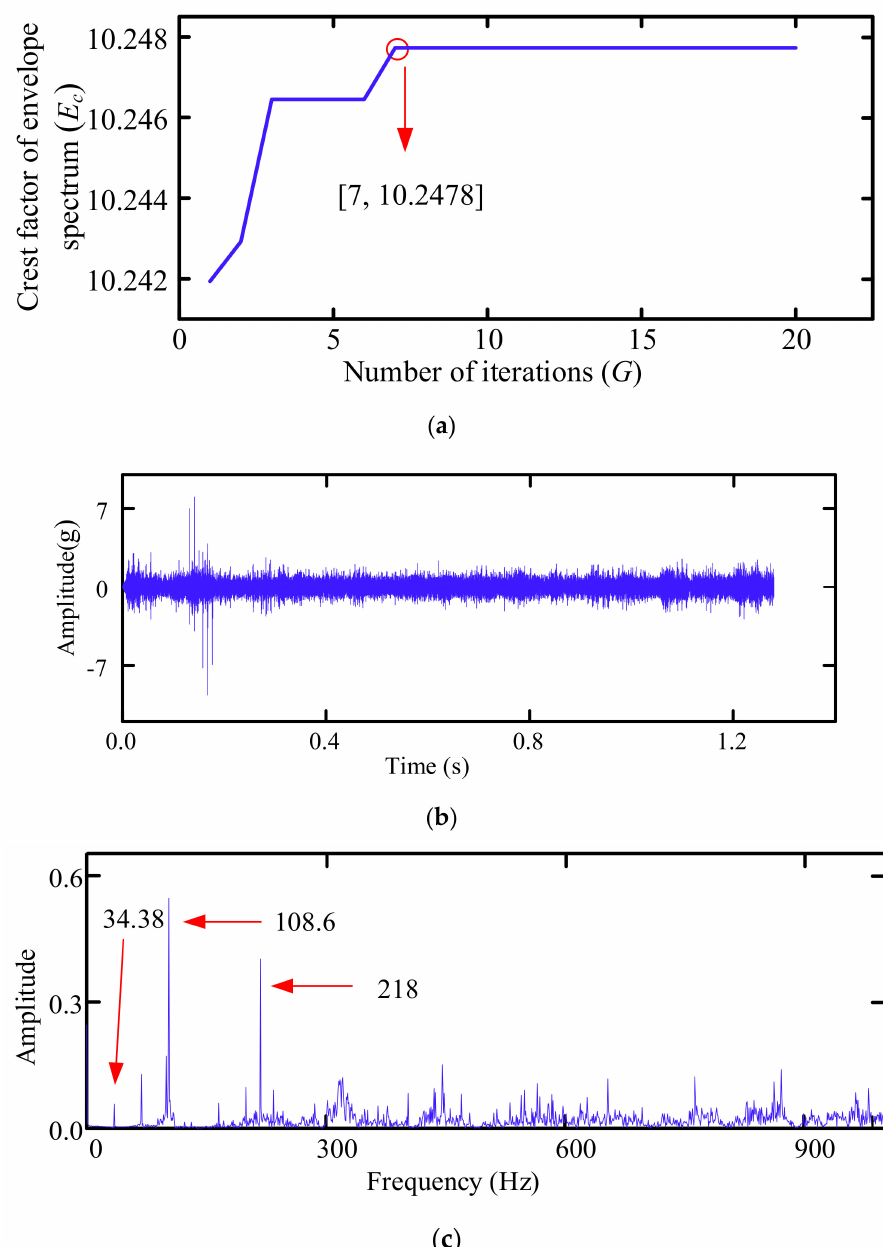
Figure 5. Time frequency diagram of deconvolution time series. ( a ) Variation curves of different E c indexes with iteration times. ( b ) Time domain diagram of deconvolution series. ( c ) Spectrum of deconvolution time